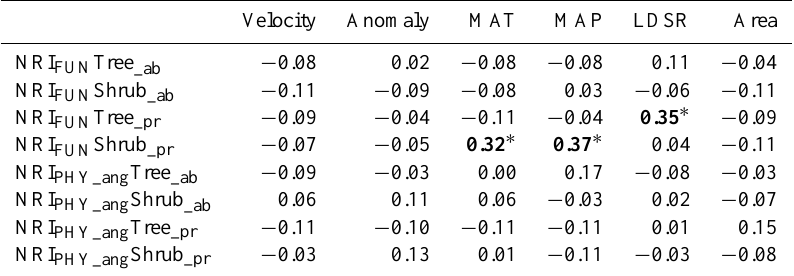
Table 4. Adjusted R 2 for single-predictor OLSs of each diversity index for the two functional groups (trees and shrubs) against each explanatory variable. Significant values are given in bold; ∗ p < 0 .